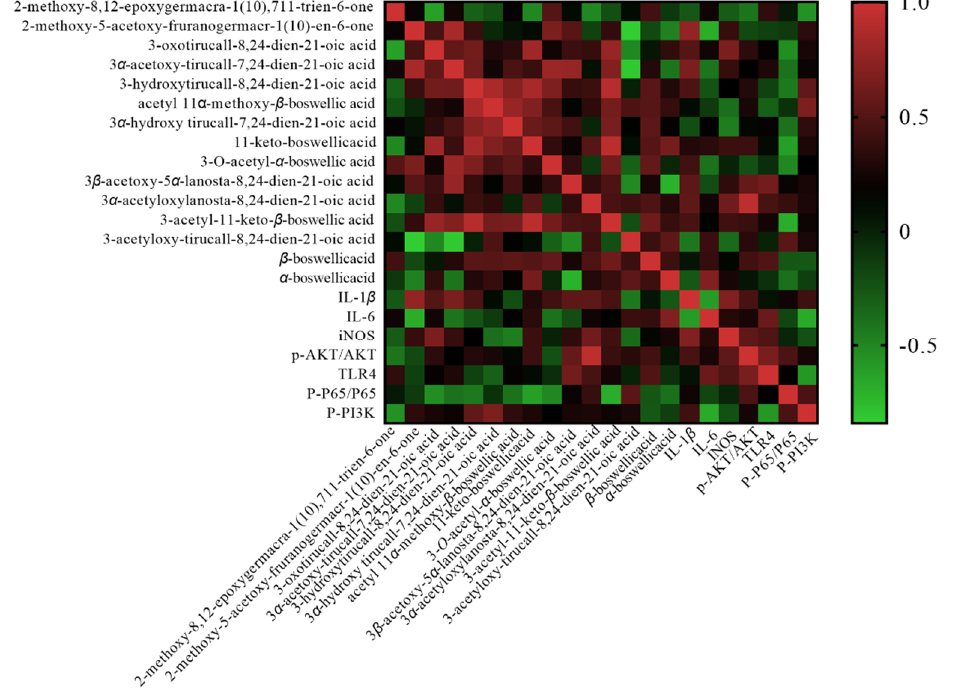
Figure 4. Heat map of biological e ff ect indexes of BV2 cells, using the main chemical components in BA and MS.